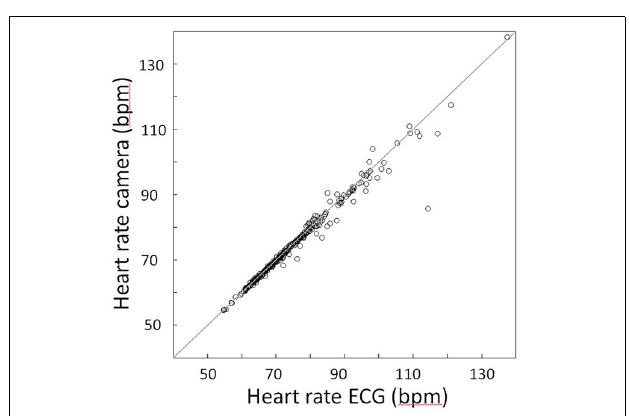
FIGURE 4 | Association between heart rate as determined by the camera and heart rate as determined by ECG. The diagonal line is the unity line. Each symbol represents the average heart rate as derived from ECG and the camera for one 1-min block for one participant.